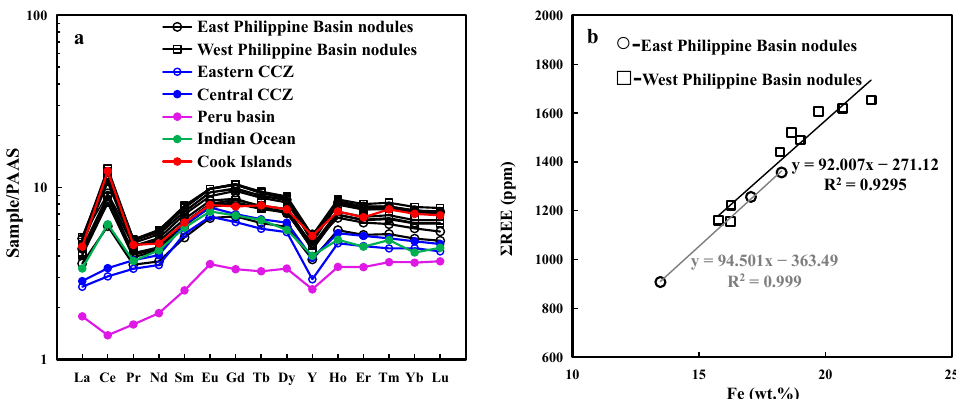
Figure 7. ( a ) PAAS [18] normalized REE + Y of bulk nodules (ICP-MS). Other data are taken from [1,19]; ( b ) Relationship of Fe with REE (from bulk analyses). REY of bulk (continuous lines) and spot LA-ICP-MS analysis.